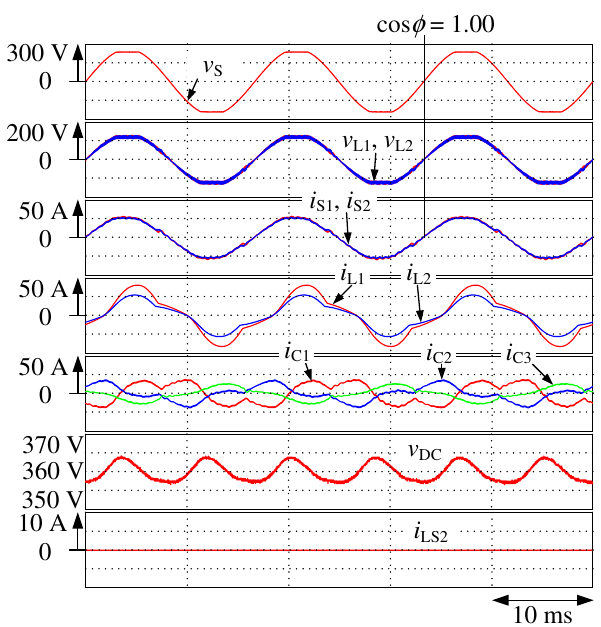
Figure 4. Simulation results for Figure 1 without battery, where BBC acts as active power-line